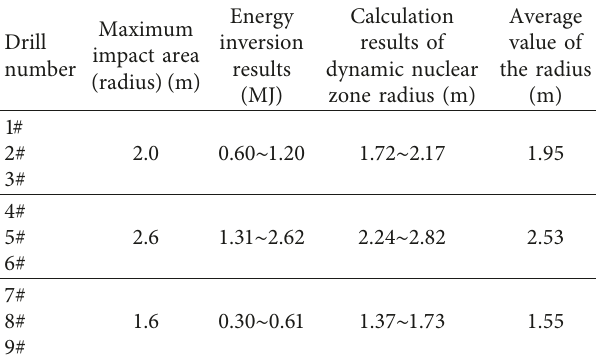
Table 4: Monitoring effect of different types of